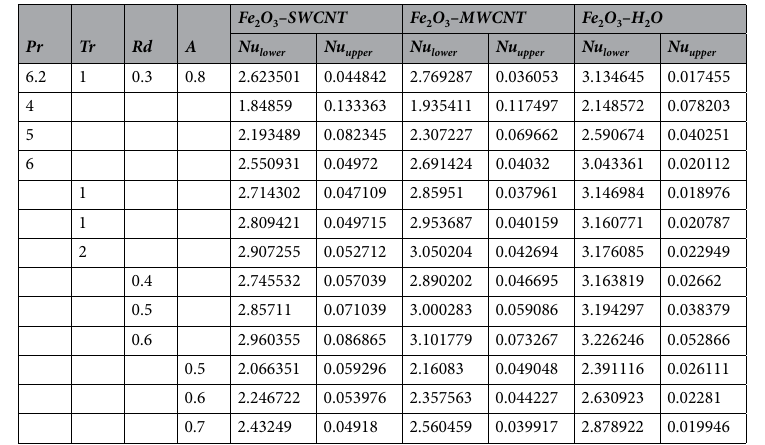
Table 3. Numerical values of Nusselt number for various parameters, whereas φ 1 = 0 – 05, φ 2 = 0 – 04, R = 15, a = 0–5, M = 0–3.